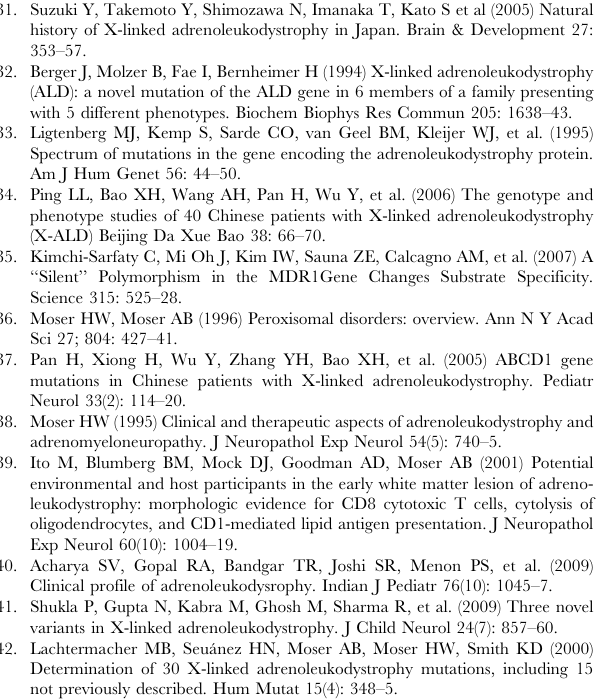
Determination of 30 X-linked adrenoleukodystrophy mutations, including 15 not previously described. Hum Mutat 15(4):